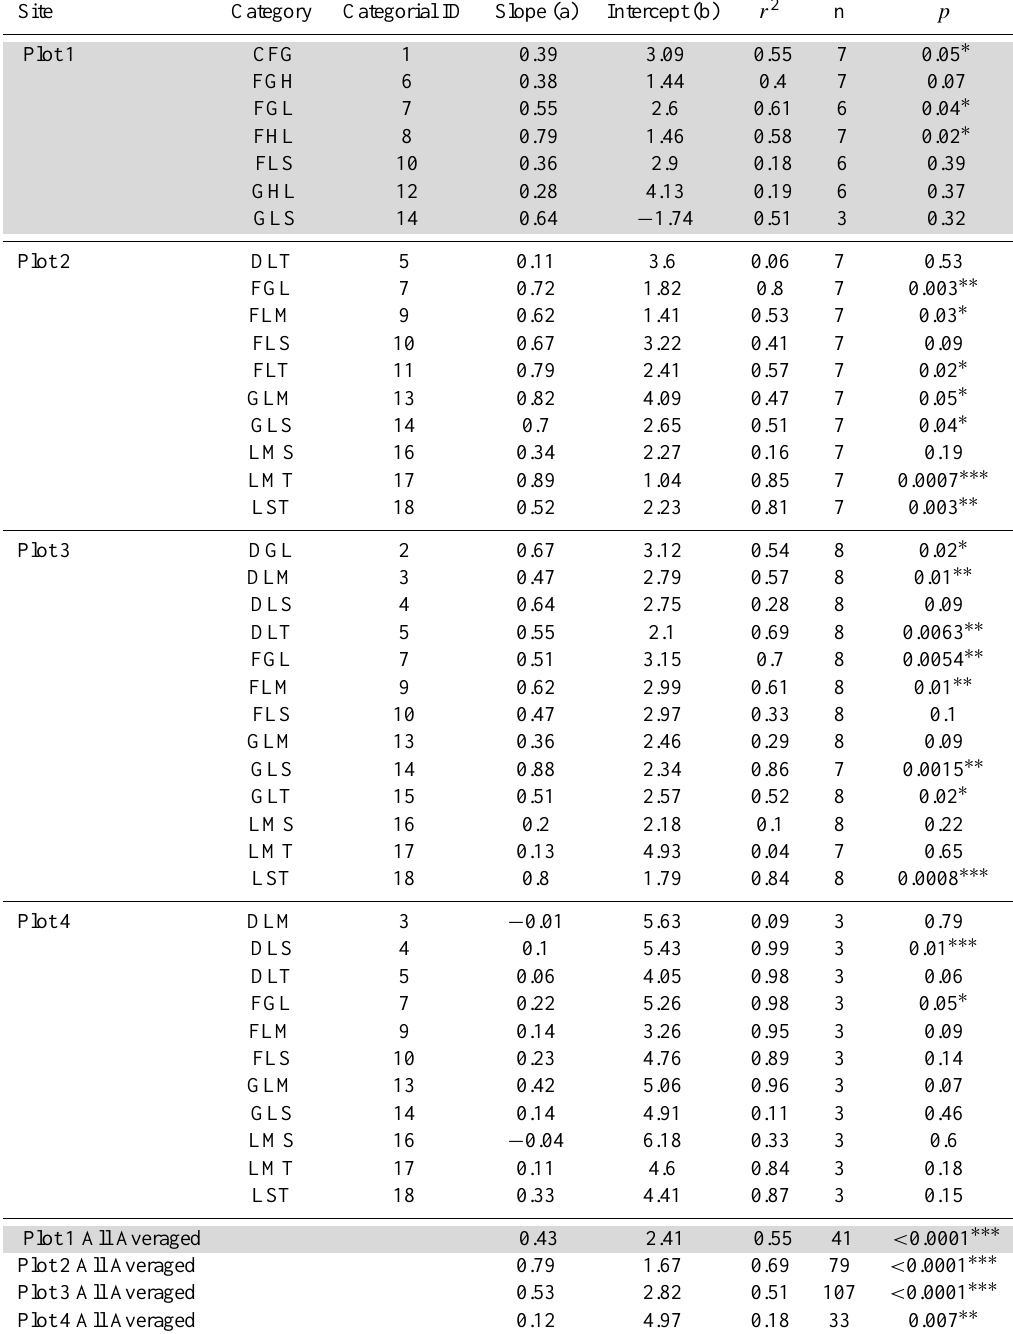
Table 3. Categories for each of the 4 plots and the statistical results of the curve fits of soil respiration ( R soil ) to soil water content ( θ) within each subplot. “*” indicate significant correlations between R soil and θ . Strong correlations were found for plot 4 where significance levels were not reached caused by insufficient amounts of data (2009 measurements only). Grey highlighted areas visualize the disturbed